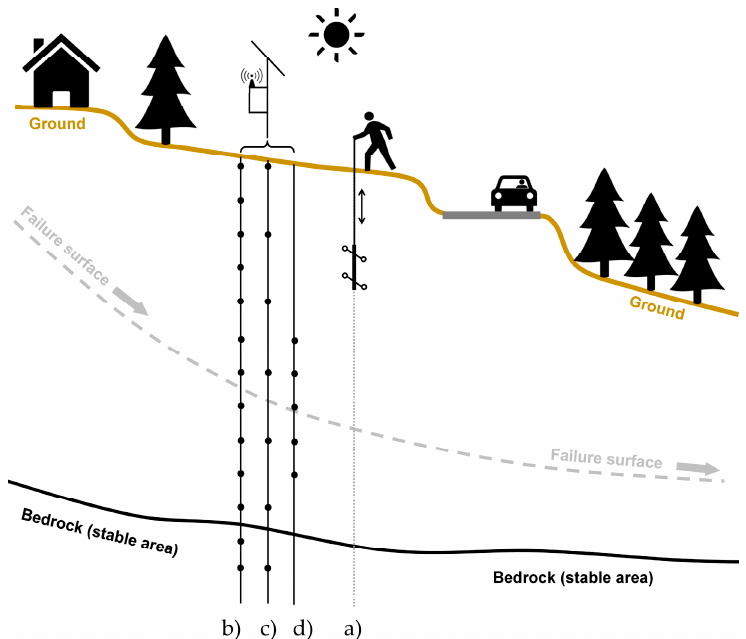
Figure 2. Standard approach to the deep-seated horizontal ground deformation. ( a ) Manual measurements with operator and portable probe; ( b ) In-Place Inclinometer (IPI) with high number of sensors for all the length of the borehole; ( c ) IPI with reduced number of sensors for all the length of the borehole; and ( d ) IPI with a reduced number of sensors only for a small part of the borehole (close to the hypothesized failure surface).